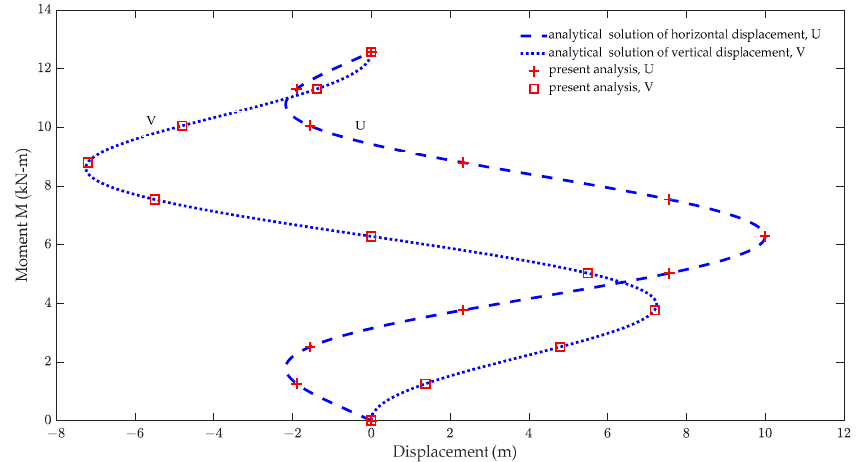
Figure 7. Load versus displacement curves for the cantilever curved beam under an end moment.